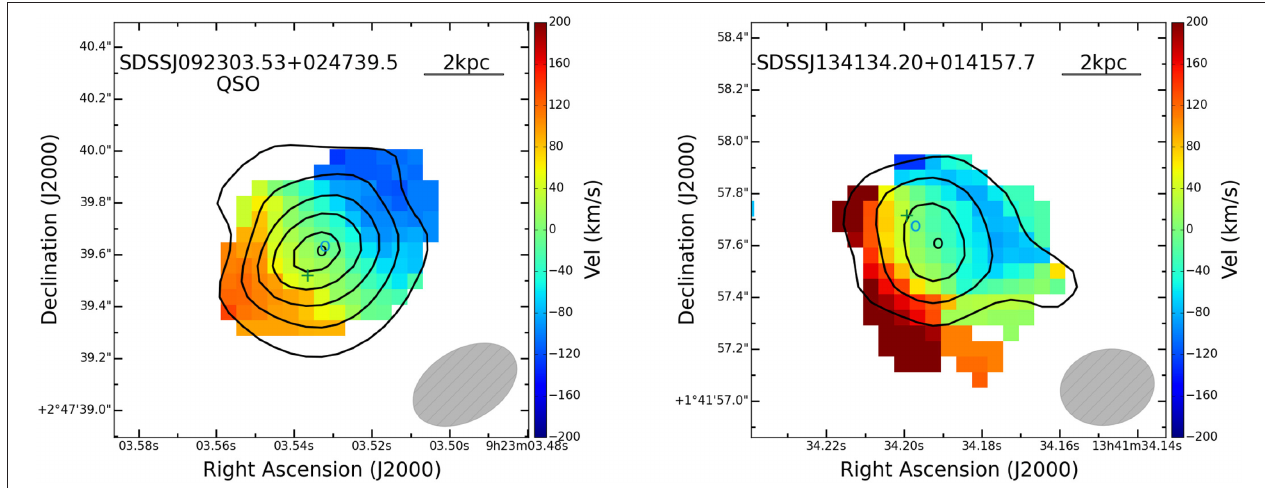
FIGURE 3 | Velocity maps of the [C II ] λ 157.74 µ m emission line for J0923 (left) and J1341 (right) , with the velocities indicated by color and the [C II ] flux contours overlaid (note that the contour levels differ between the two sources). The kinematics of the cold gas in the host galaxies appears to be dominated by